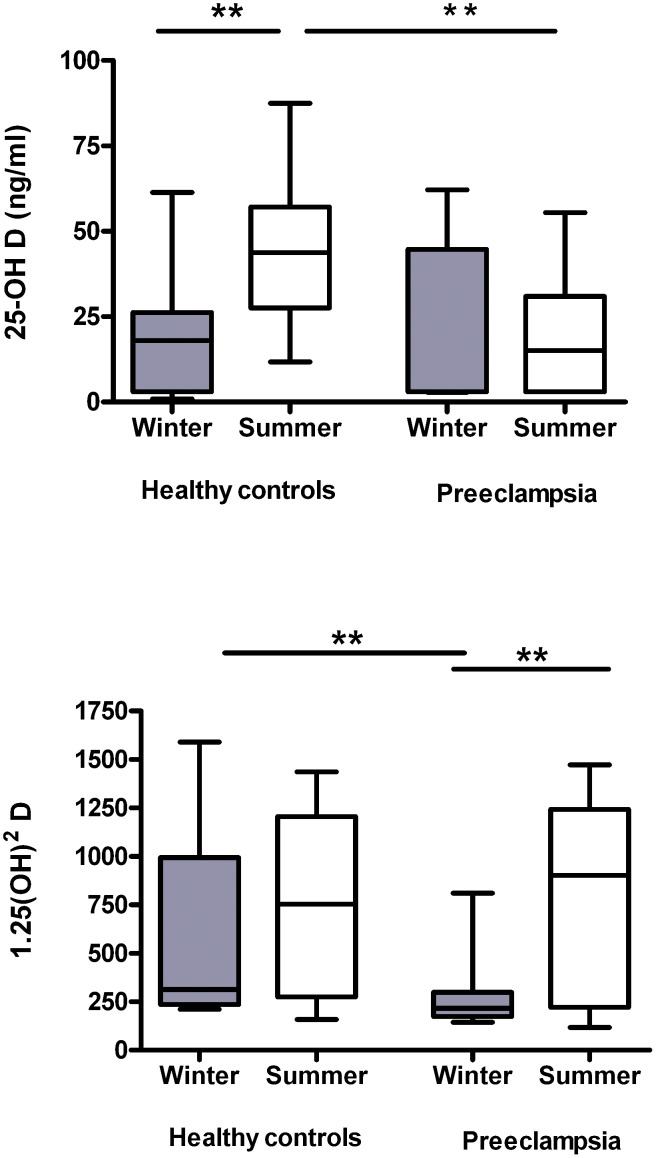
Boxplots showing the smallest observation (lower bar), lower and upper quartile (box), median (line in the box) and largest observation (upper bar) of a) maternal 25-OH vitamin D serum levels (ng/mL) in winter (grey box) and summer (open box).Maternal 25-OH vitamin D levels differ between patients with preeclampsia and healthy controls in the summer (** p<0.01). b) Maternal 1,25-(OH)2 vitamin D (pmol/mL) serum levels are similar in both groups, but significantly lower during winter months in patients with preeclampsia (** p<0.01).